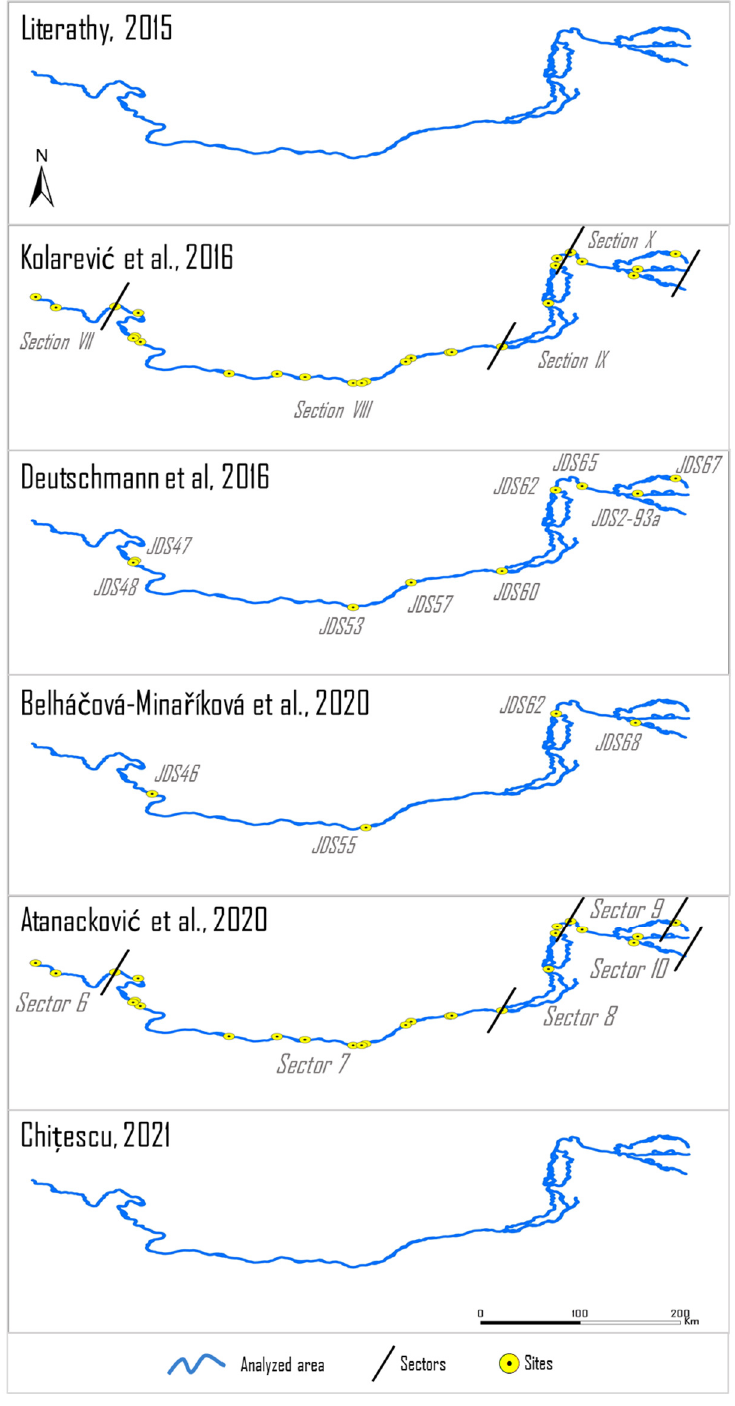
Figure 6. The sites and sections sampled and analyzed on the entire Romanian Danube [25,29–32,58]. Literathy [30] used the fluorescence analytical method for PAH and petroleum hy- drocarbons contamination measurements in water, suspended particulate matter (SPM), bottom sediment samples and biota (mussels). The scientist focused on anthracene, benzene, fluoranthene, naphthalene, benzo[a]pyrene (petroleum hydrocarbons) and